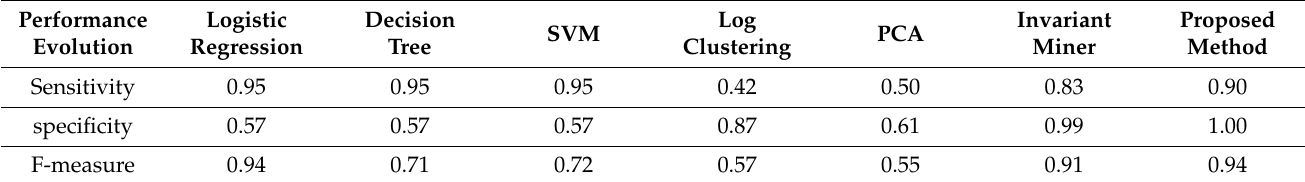
Table 14. Comparison with existing